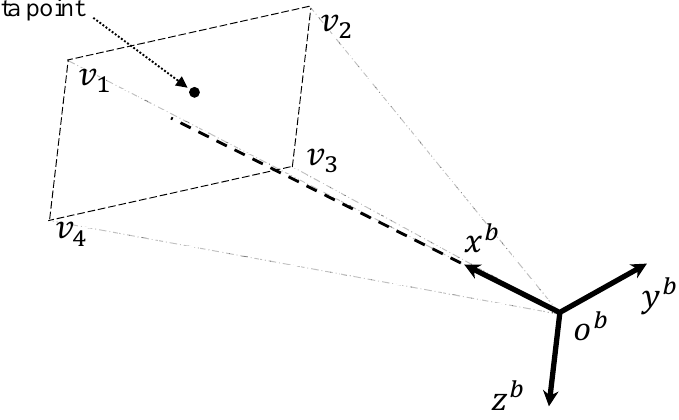
Figure 2. Obstacle data acquisition with Light Detection And Ranging (LiDAR).